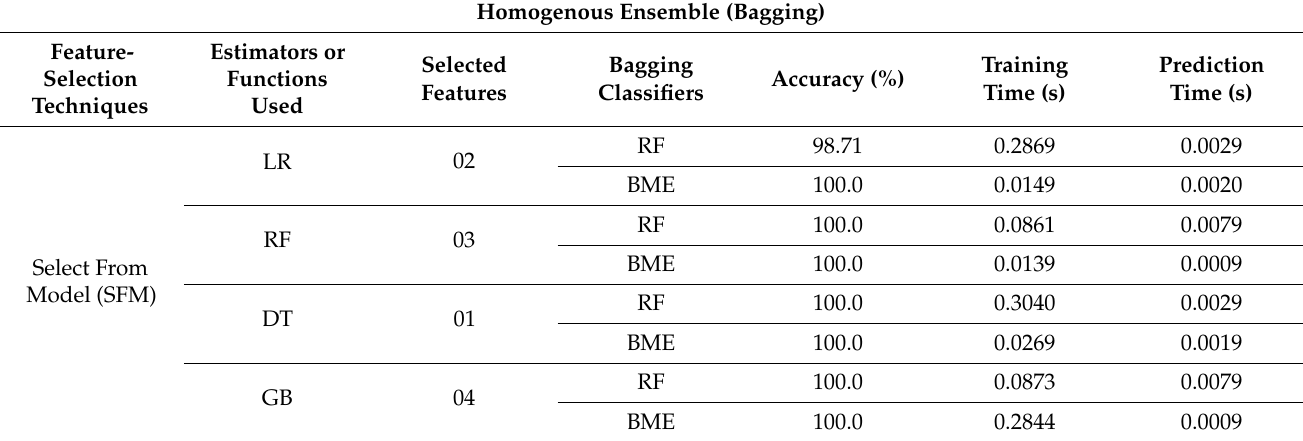
Table 4. Description of the accuracy with training and prediction time for the bagging classifiers. Homogenous Ensemble